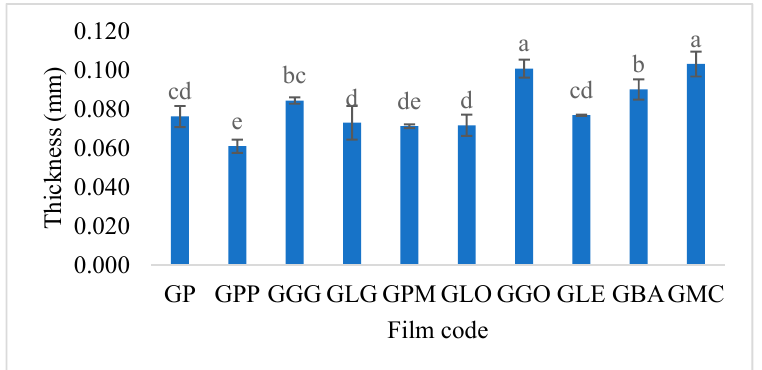
Figure 1. Thickness of studied edible films incorporating essential oils and plant extracts. Data are means ± standard deviations. Data of each column not sharing similar letters are significantly different, at p < 0.05.